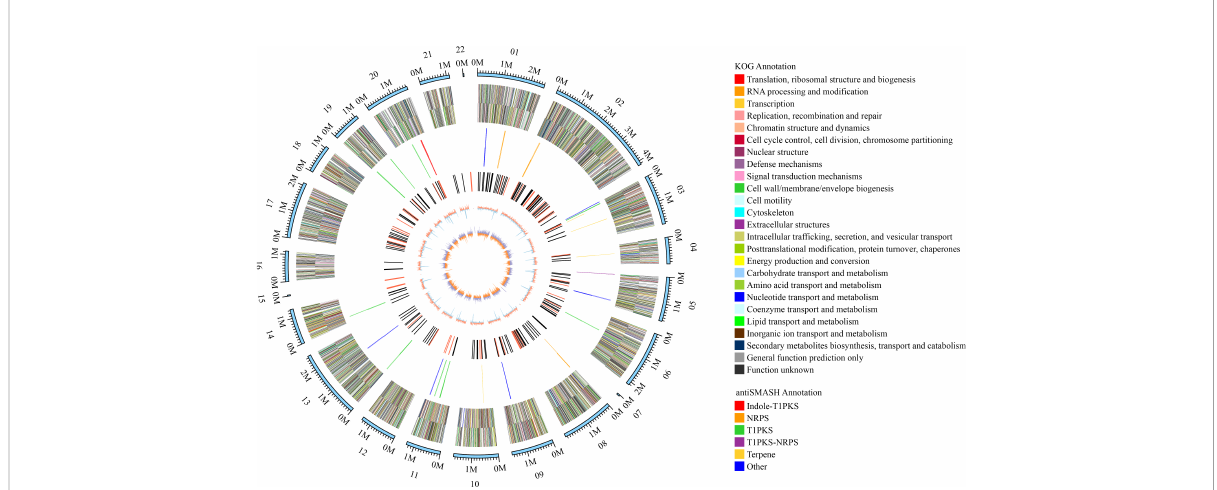
FIGURE 5 Circular map of genomic features of Epicoccum latusicollum HGUP191049. The peripheral circles represent the scaffolds (Mb scale), consisting of 22 scaffolds. From outer to inner circles (second to the sixth circle) are KOG annotation (forward and reverse strands), different colors indicate different functional classi fi cation; antiSMASH annotation (forward and reverse strands), different colors indicate different types of biosynthetic gene clusters (BGCs); ncRNA (black indicates tRNA, red indicates rRNA); GC content (red indicates greater than the mean, blue indicates less than the mean); GC skew (used to measure the relative content of G and C, GC skew = (G-C)/(G+C); purple indicates greater than 0, orange indicates less than